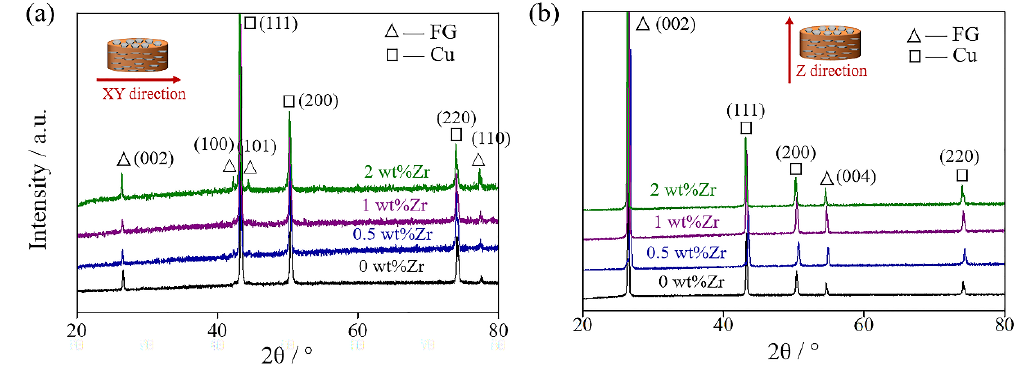
Figure 5. XRD results of FG/Cu composites with different Zr contents in ( a ) XY and ( b ) Z direction, respectively.